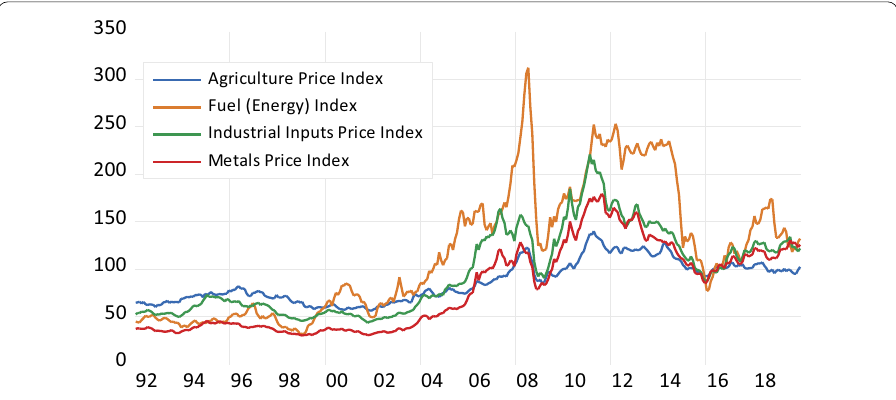
Fig. 1 Commodity and energy price indexes. Source : International Monetary Fund